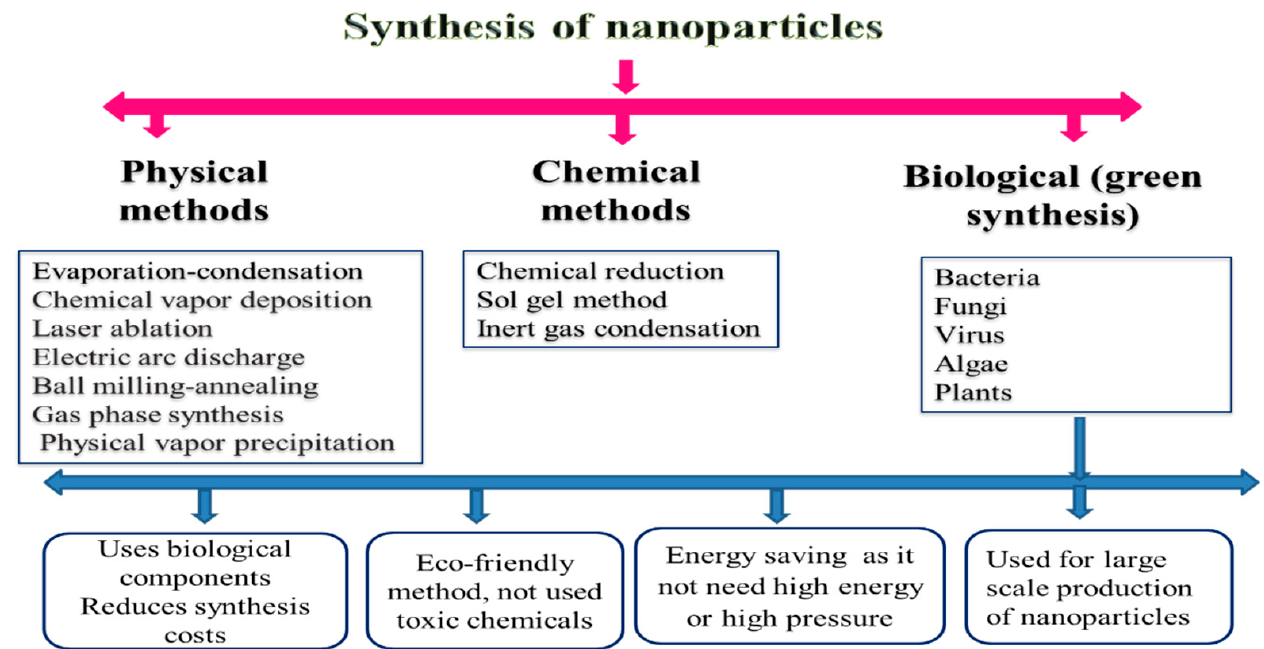
Figure 1. Preparation and synthesis of nanoparticles.